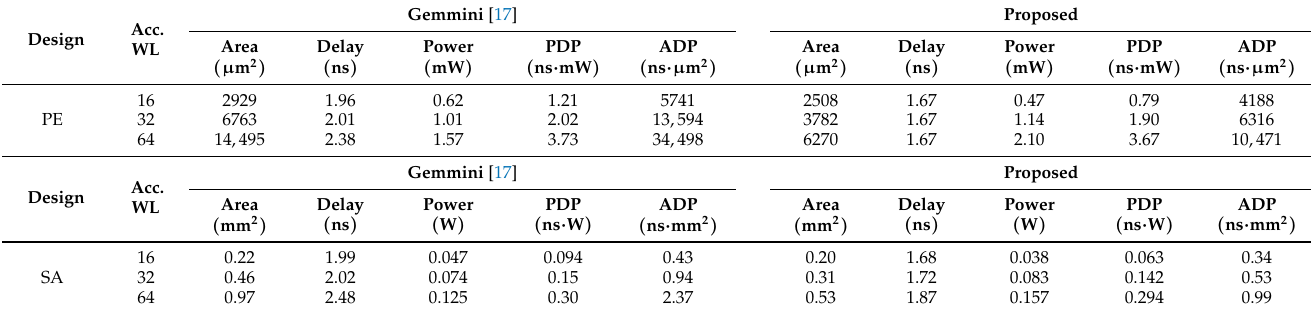
Table 3. Implementation results for 16, 32 and 64-bit accumulator word-length (acc. WL) Gemmini and proposed CPA- Factored Gemmini SAs.